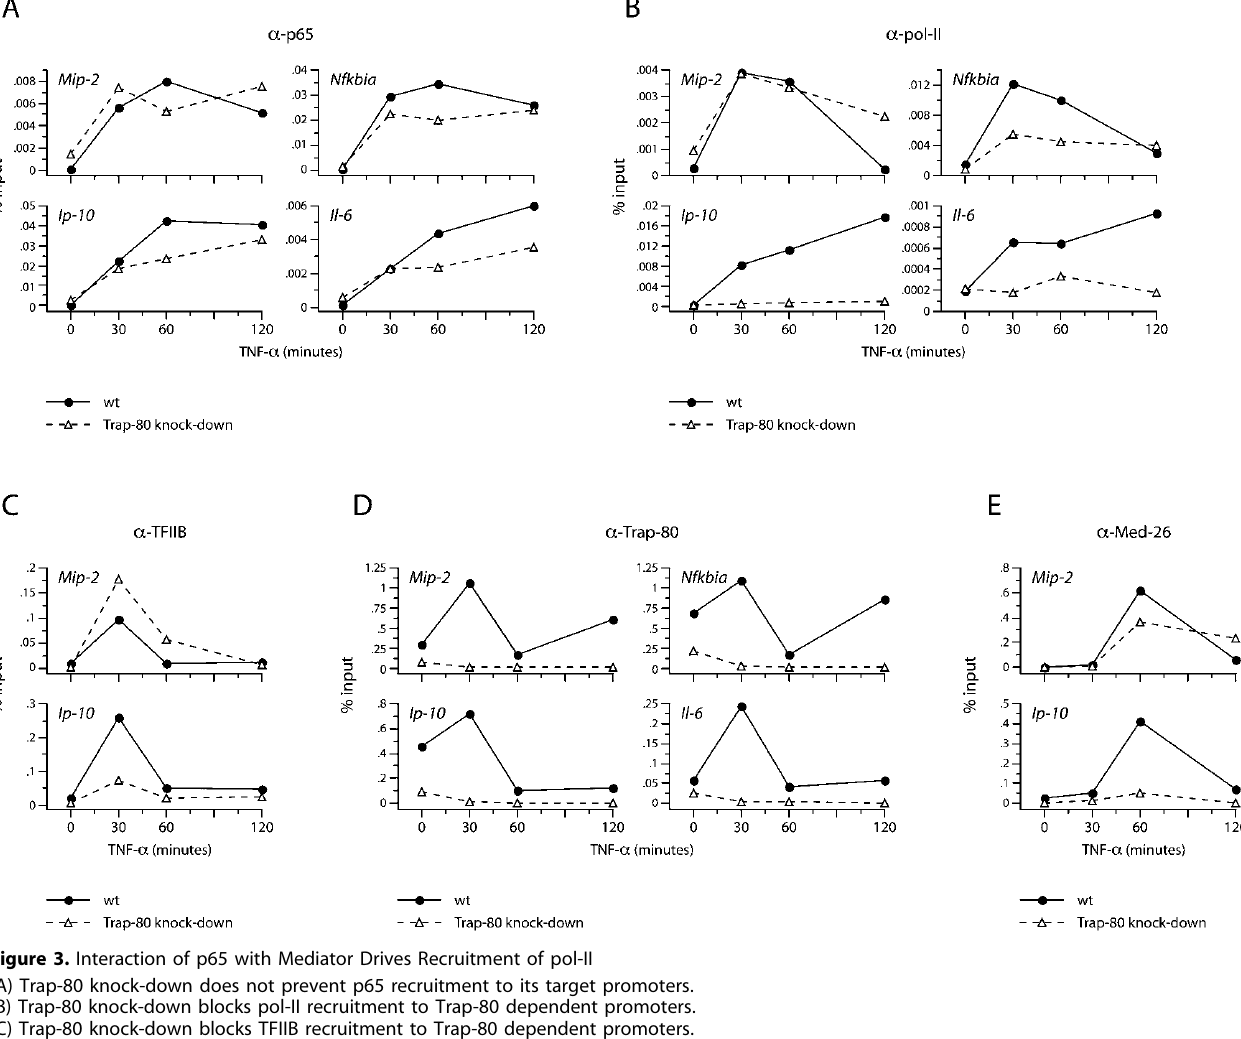
Figure 3. Interaction of p65 with Mediator Drives Recruitment of pol-II (A) Trap-80 knock-down does not prevent p65 recruitment to its target promoters. (B) Trap-80 knock-down blocks pol-II recruitment to Trap-80 dependent promoters. (C) Trap-80 knock-down blocks TFIIB recruitment to Trap-80 dependent promoters. (D) Presence of Trap-80 at promoter regions. (E) Trap-80 knock-down blocks Med-26 recruitment to Trap-80 dependent promoters. ChIP using antibodies against p65 (A), pol-II (B), TFIIB (C), Trap-80 (D), and Med-26 (E), after stimulation with TNF- a . Bound DNA was analyzed using primers and probes specific for promoter regions. The amounts are presented as the percentage recovered out of the total input DNA (percent input). All measurements were performed in duplicate; the results presented here are representative of two to five